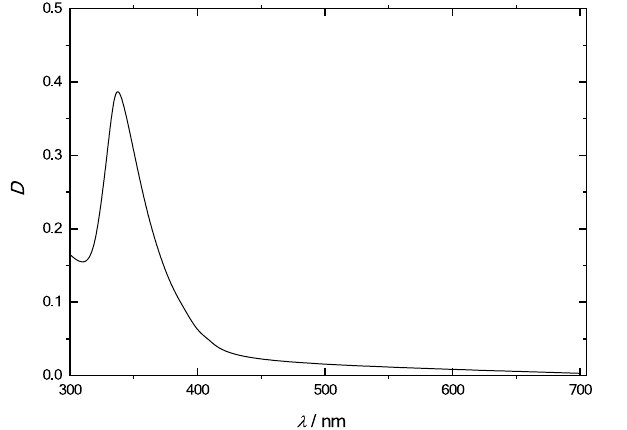
Figure 6. Absorption spectrum of fullerene C 60 in olive oil.